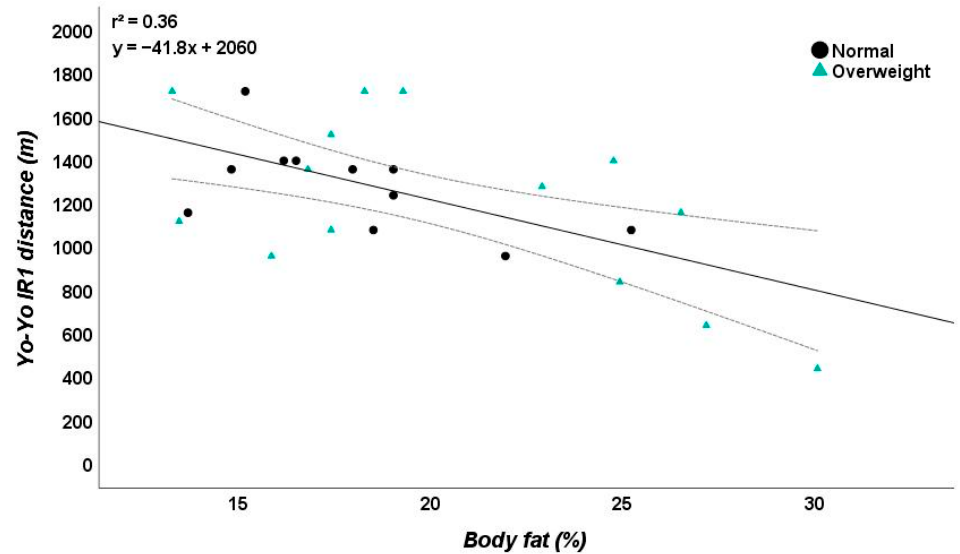
Figure 1. Relationship between body fat and agility depending on the group. Please note that one dot can represent several subjects.